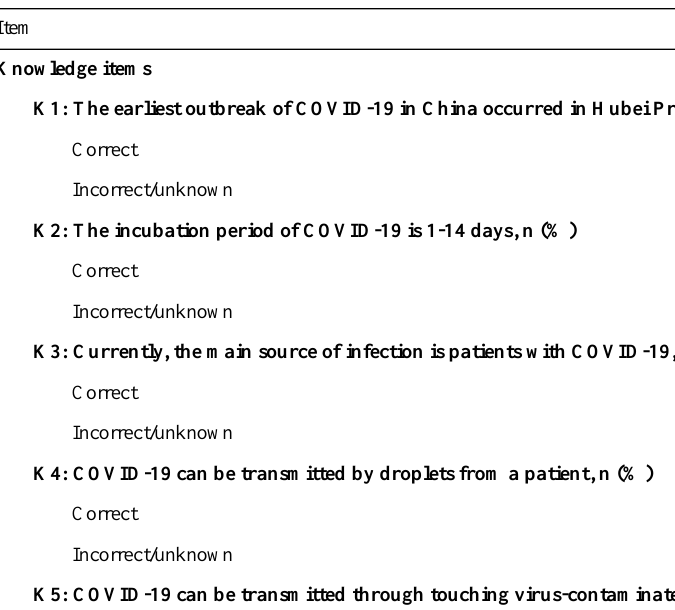
Table 1. Participants’knowledge and perceived beliefs regarding COVID-19